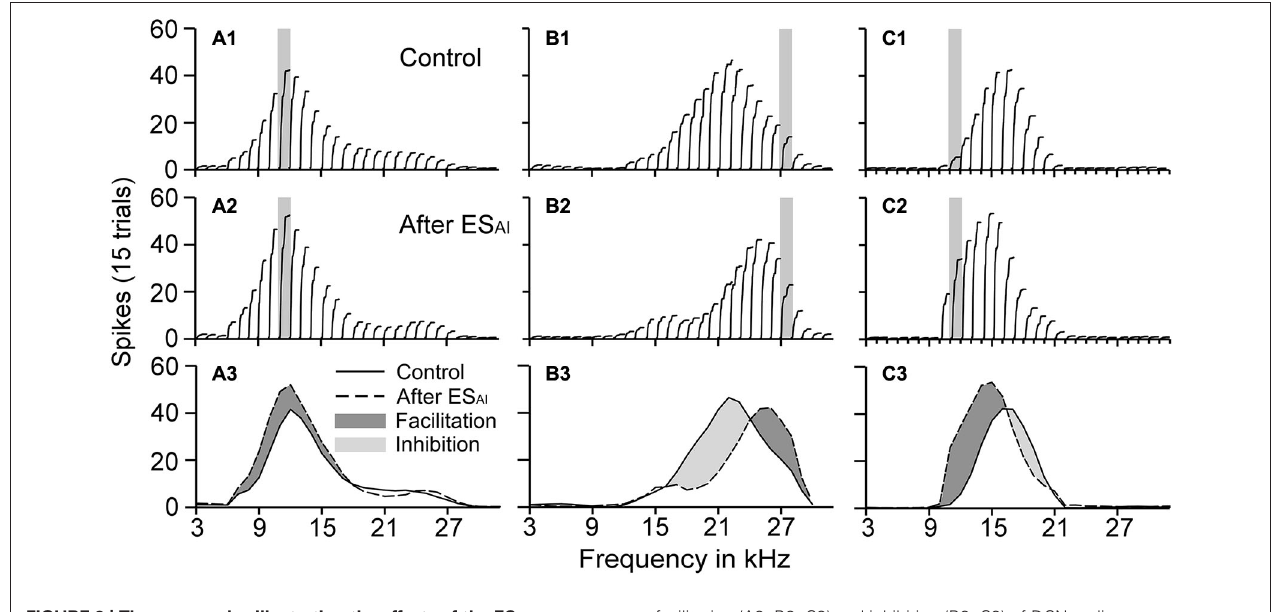
FIGURE 2 | Three examples illustrating the effects of the ES AI on the frequency tunings of DCN neurons (A–C) . The ES AI did not change the BF but increased the auditory responses of the matched DCN neurons (A1, A2), while the BFs of the unmatched DCN neurons shifted towards the cortical BF (B1, B2 and C1, C2). The ES AI caused